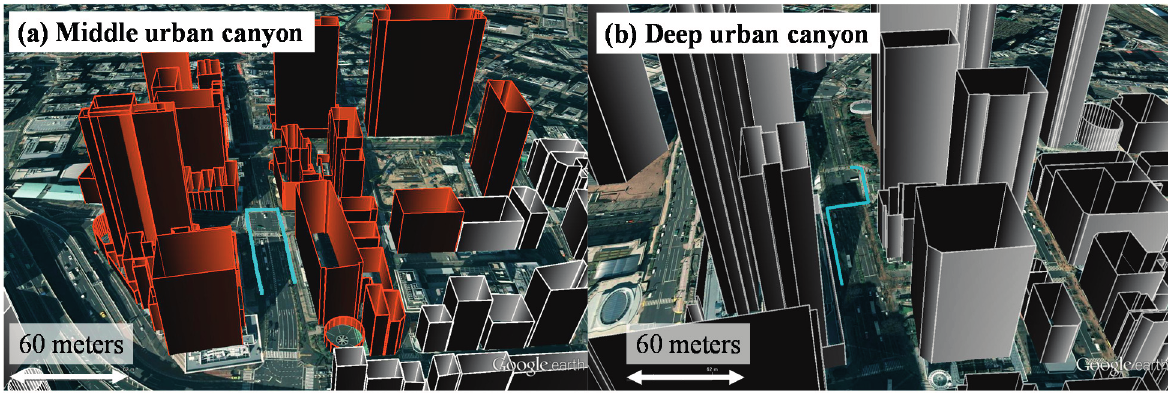
Figure 6. Constructed 3D building models in the middle and deep urban